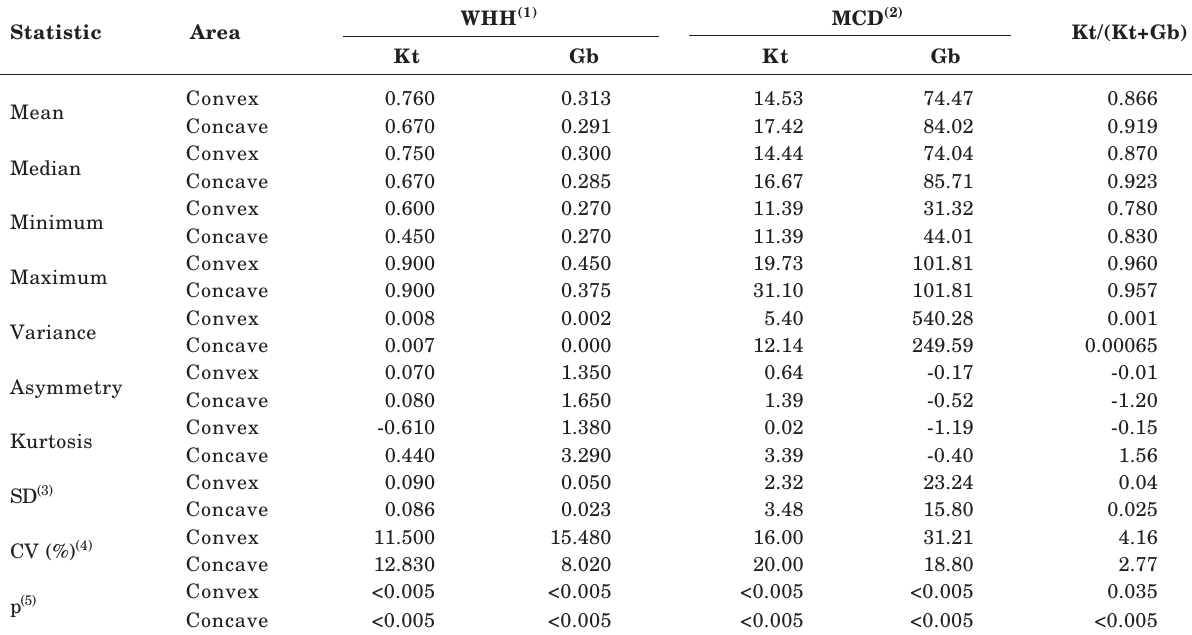
Table 3. Descriptive statistics of the mineral properties [width at half height, mean crystallite size, and Kt/ (Kt+Gb) ratio] for the convex and concave areas in the 0.0-0.2 m